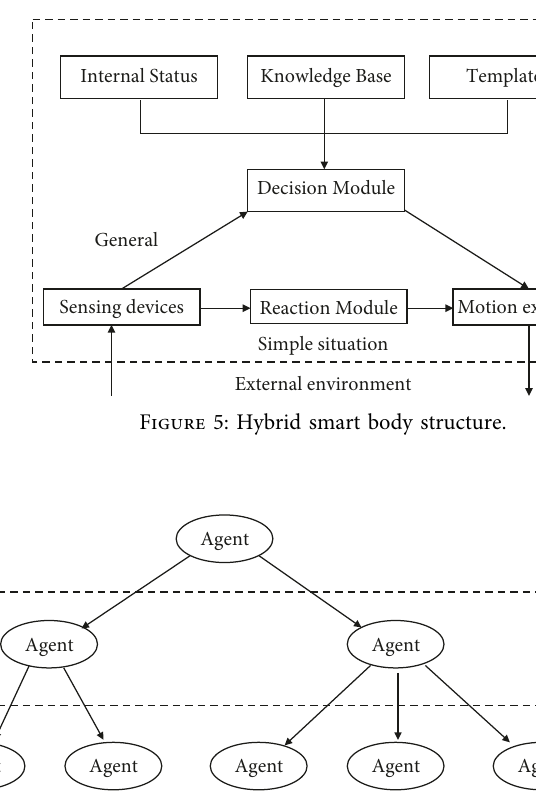
Figure 6: Centralized MAS structure.